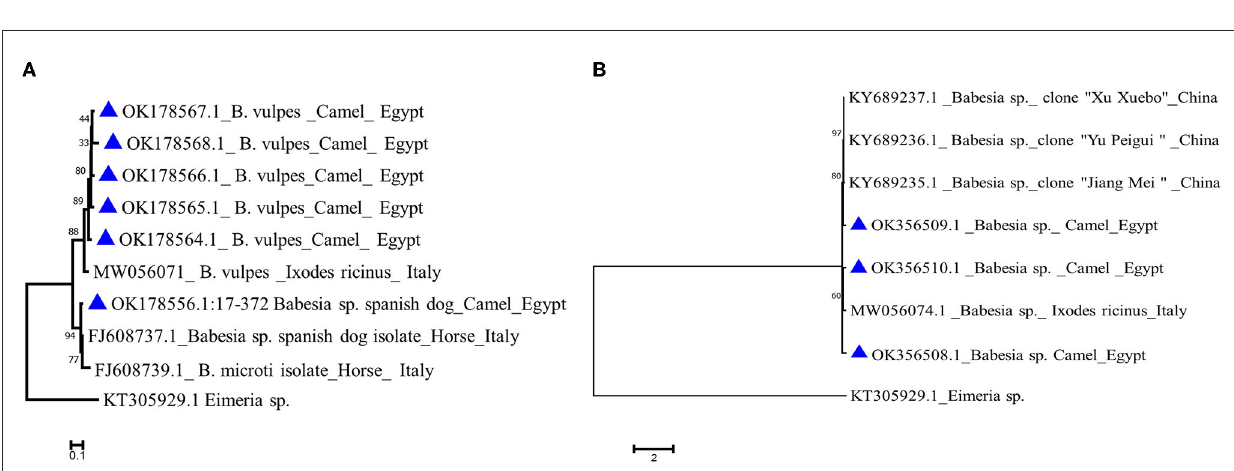
FIGURE5 Phylogenetic analysis using the Maximum Likelihood method (A) Babesia vulpes 18S gene of camel isolates (labeled with triangle symbol) with other reference sequences identified by blast analysis and deposited in GeneBank (accession numbers shown in the tree). (B) Babesia sp. 18S gene of camel isolates in the present study labeled with a triangle symbol with other reference sequences identified by blast analysis and deposited in GeneBank (accession numbers shown in the tree). Eimeria sp . COI gene is used as an outgroup. The tree was created by MEGA 7